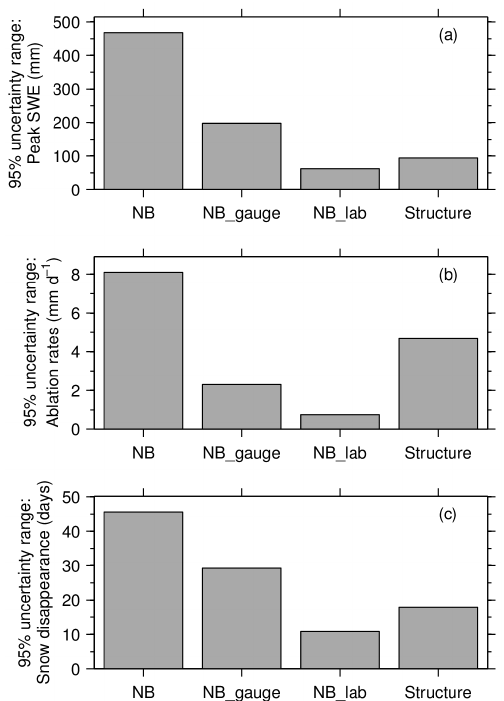
Figure 9. Uncertainty ranges (95% intervals) in (a) peak SWE, (b) ablation rates, and (c) snow disappearance date at CDP in WY2006 for three forcing uncertainty scenarios and the Essery et al. (2013) structural